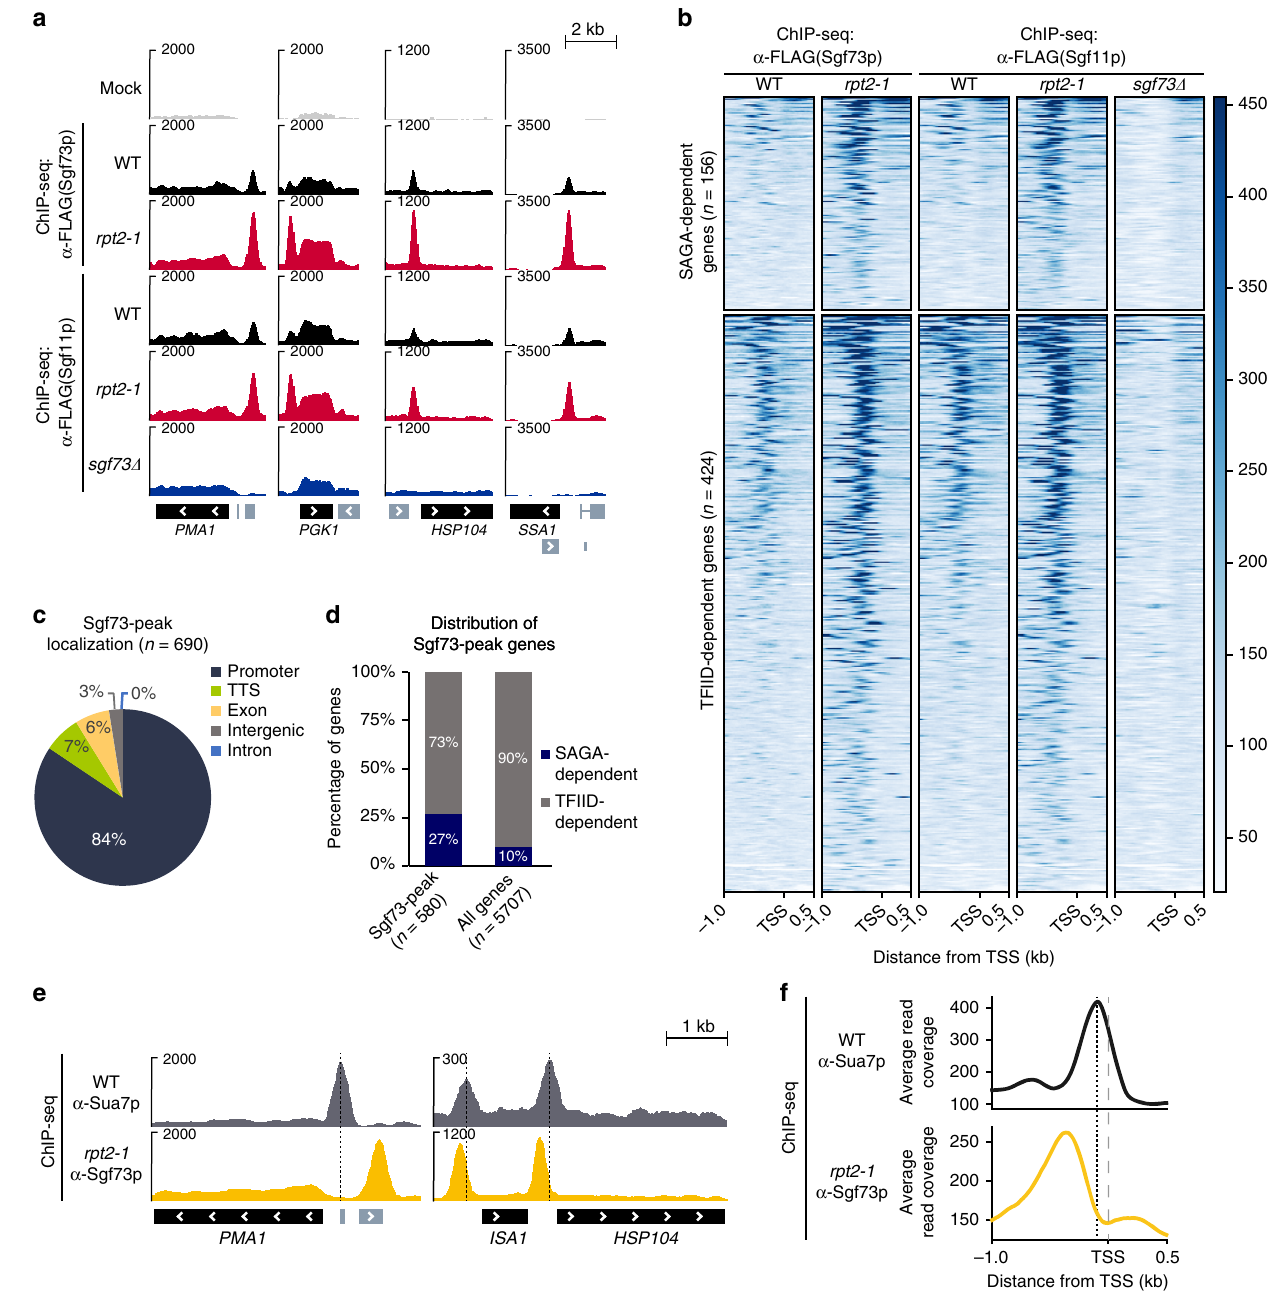
Fig. 3 Sgf73p is globally retained in the UAS elements of genes in rpt2-1 . a Genome browser view of the PMA1 , PGK1 , HSP104 , and SSA1 genes showing the ChIP-seq pro fi les of Sgf73p and Sgf11p in mock, wildtype, rpt2-1 , and sgf73 Δ cells. b Heatmaps of ChIP-seq signals representing Sgf73-DUBm binding ( α - Sgf73p and α -Sgf11p) in wildtype, rpt2-1 , and sgf73 Δ cells 1 kb upstream and 0.5 kb downstream of the TSS in the Sgf73-peak gene set ( n = 580). Heatmaps were divided into SAGA-dependent genes ( n = 156) and TFIID-dependent genes ( n = 424) and sorted in descending order of Sgf73p enrichment. The y - axis color scale indicates normalized ChIP-seq read count. c Pie chart showing the Sgf73-peak localization pattern. d Bar graph indicating the distribution of Sgf73-peak genes within the SAGA-dependent genes (73%) and TFIID-dependent genes (27%). e Genome browser view of the PMA1 , ISA1 , and HSP104 genes showing the ChIP-seq pro fi les of Sua7p in wildtype and Sgf73p in rpt2-1 cells. Dotted lines indicate Sua7p peak sites. f Average plots of ChIP-seq signals representing the binding of Sua7p and Sgf73p in wildtype and rpt2-1 cells. Dashed and dotted lines indicate the TSS and Sua7p-binding sites, respectively. kb, kilobase. TSS, transcription start